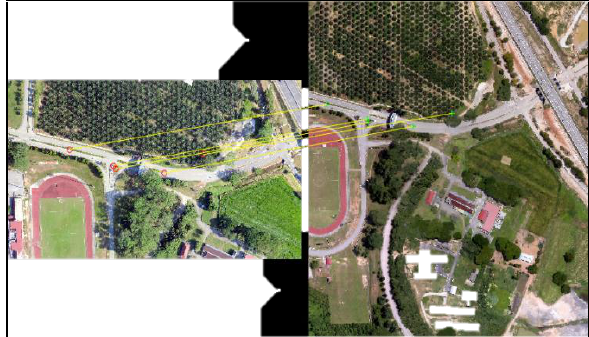
Figure 5. Best matching features by using band 3 of UAV and LiDAR orthophoto and projective transformation